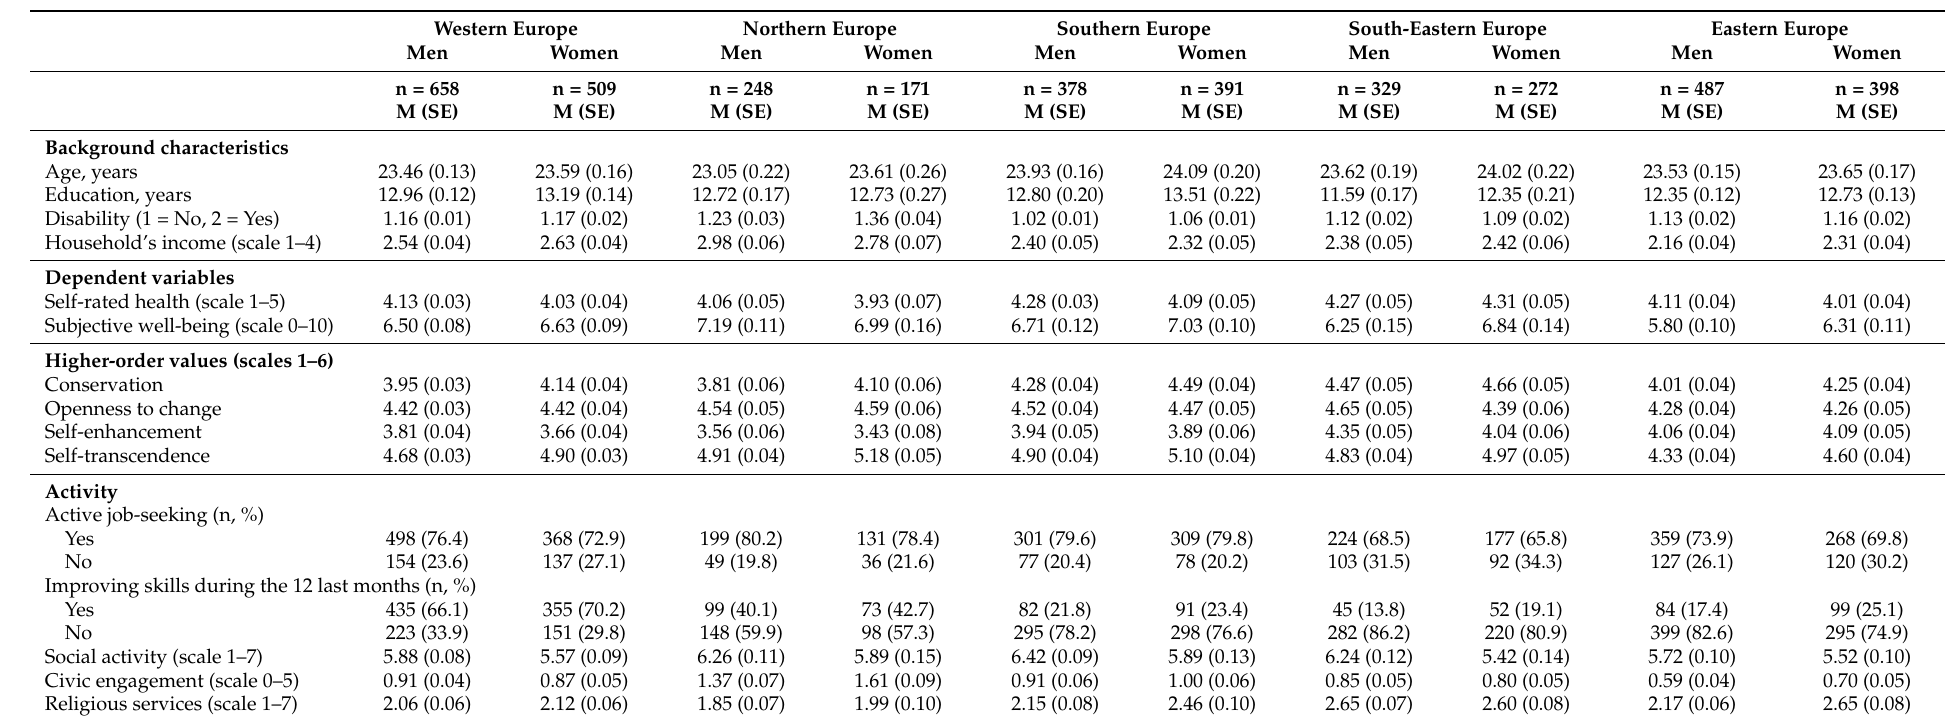
Table 2. Descriptive statistics (Mean, SE) stratified by gender and European